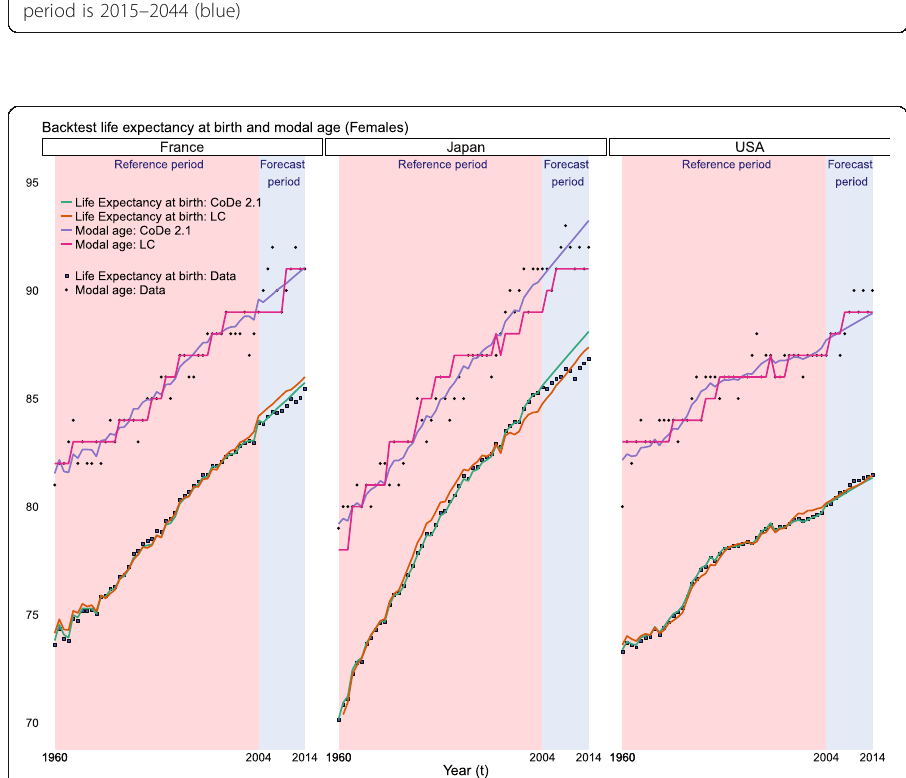
Fig. 4 Estimation and in-sample projections of life expectancy at birth and the modal age of females using the CoDe 2.1 model and the LC model. The reference period is 1960 – 2004 (pink); the projection period is 2005 – 2014